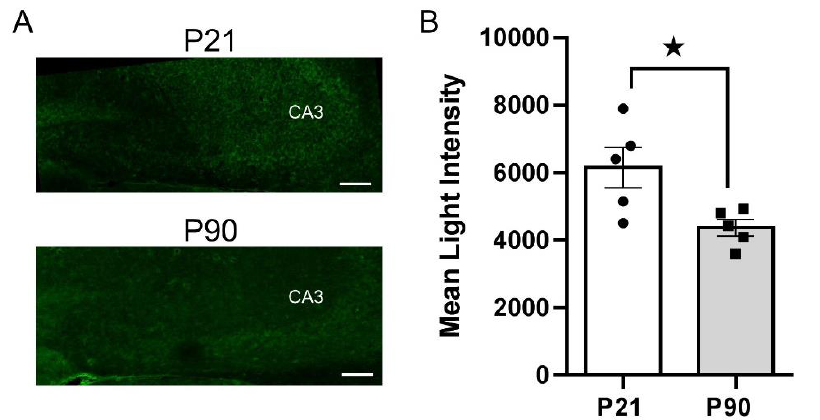
Figure 5. Juvenile mice express higher levels of PMAT in CA3 region of hippocampus. ( A ) Repre- sentative 10 × images from juvenile (P21) (top) and adult (P90) (bottom) mice. The mean intensity of light measurements was taken from the same area as that indicated in cell count data (Figure 3). ( B ) Summary data showing the difference in PMAT expression between juvenile (open bar, circles) and adult (grey bar, squares) mice. * p < 0.05, unpaired t-test for independent samples. Data are mean ± S.E.M. n = 5 per age. Scale bar = 100 µM.